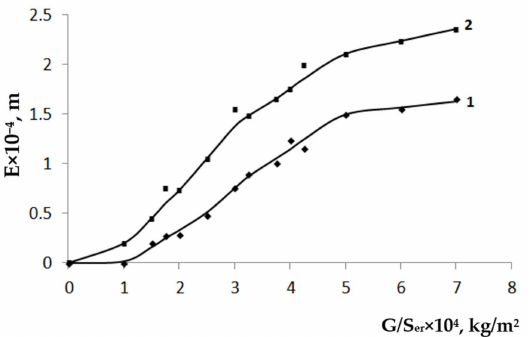
Figure 11. Curves of the kinetics of erosion wear: ( 1 ) samples without coating; ( 2 ) coated samples; E—the average depth of erosion, equal to the ratio of the decrease in the volume of the material to the area of the eroded surface; G/S er —the volume of liquid falling out per unit surface